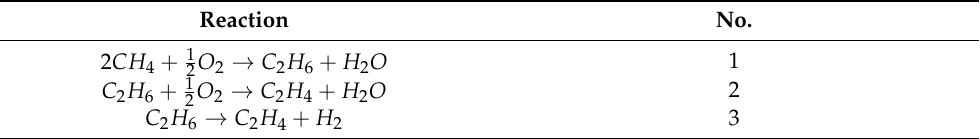
Table 1. Possible global reactions involved in the OCM reaction mechanism [91,92]. Reaction No.